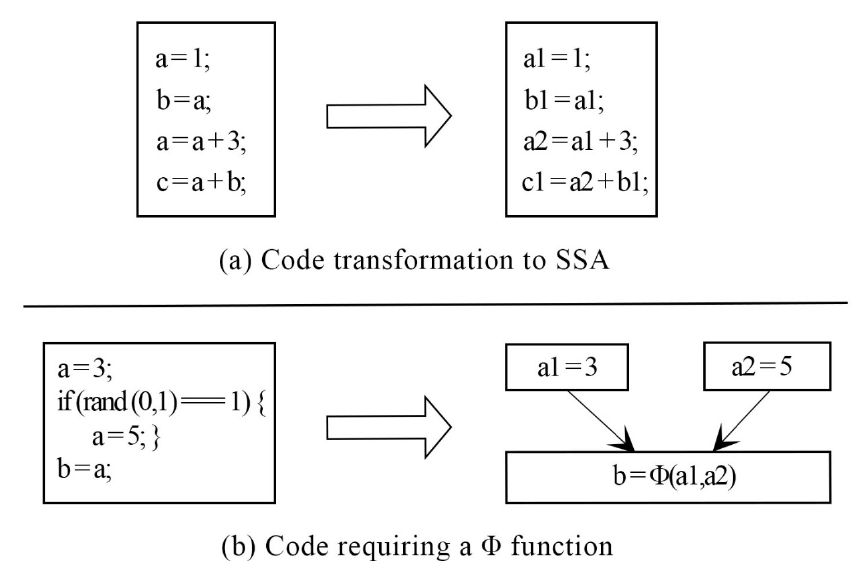
Figure 2. Example of static single assignment (SSA) representation and φ function. ( a ) Variable renaming. ( b ) A code corresponding to the φ function usage and a simplified graph